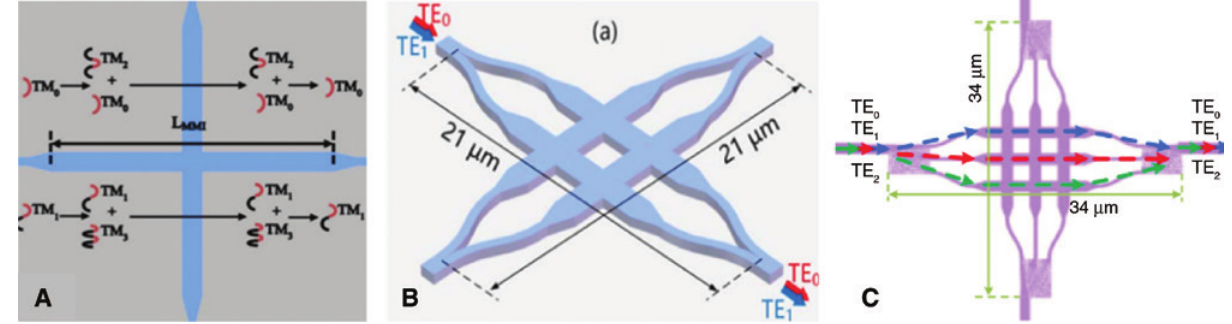
Figure 10: On-chip multimode waveguide crossings. (A) A two-mode waveguide crossing with two crossed MMI sections [110]. (B) A two-mode waveguide crossing with Y-junction based mode converters [111]. (C) A three-mode waveguide crossing with 1 × 3 mode (de)multiplexers and a 3 × 3 array of single-mode waveguide crossings